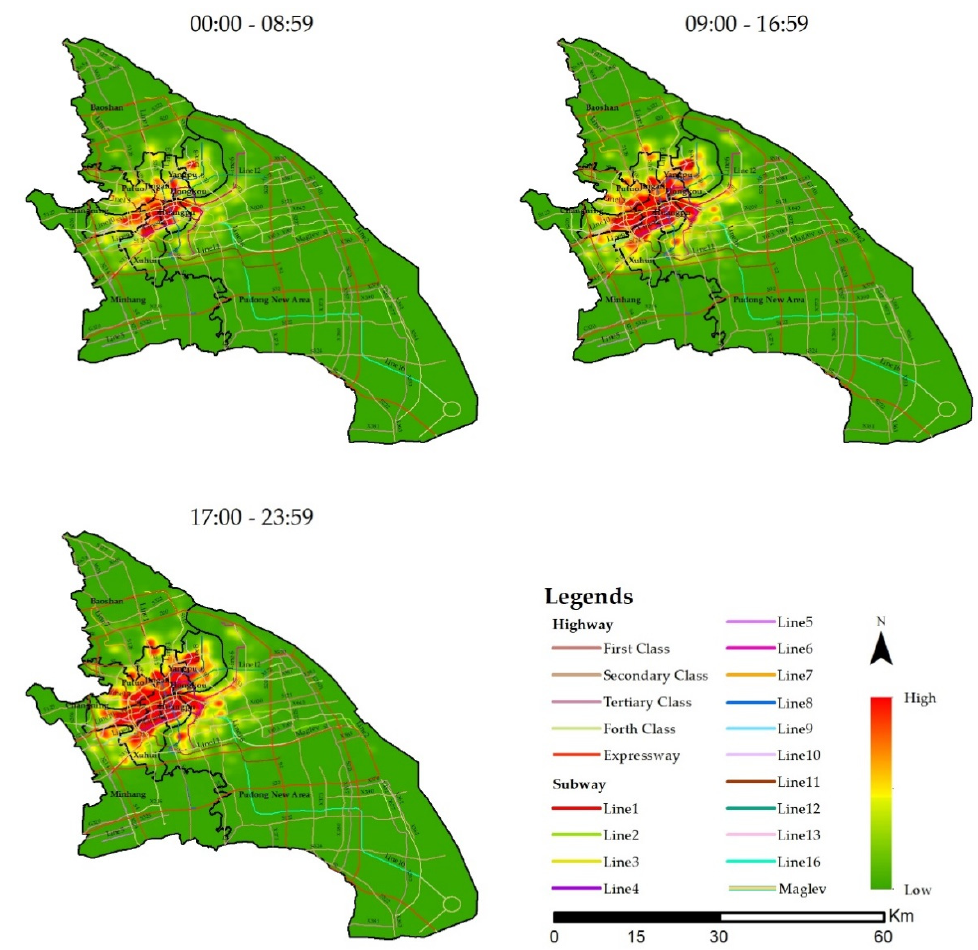
Figure 17. Check ‐ in density of females for different hours of the day.